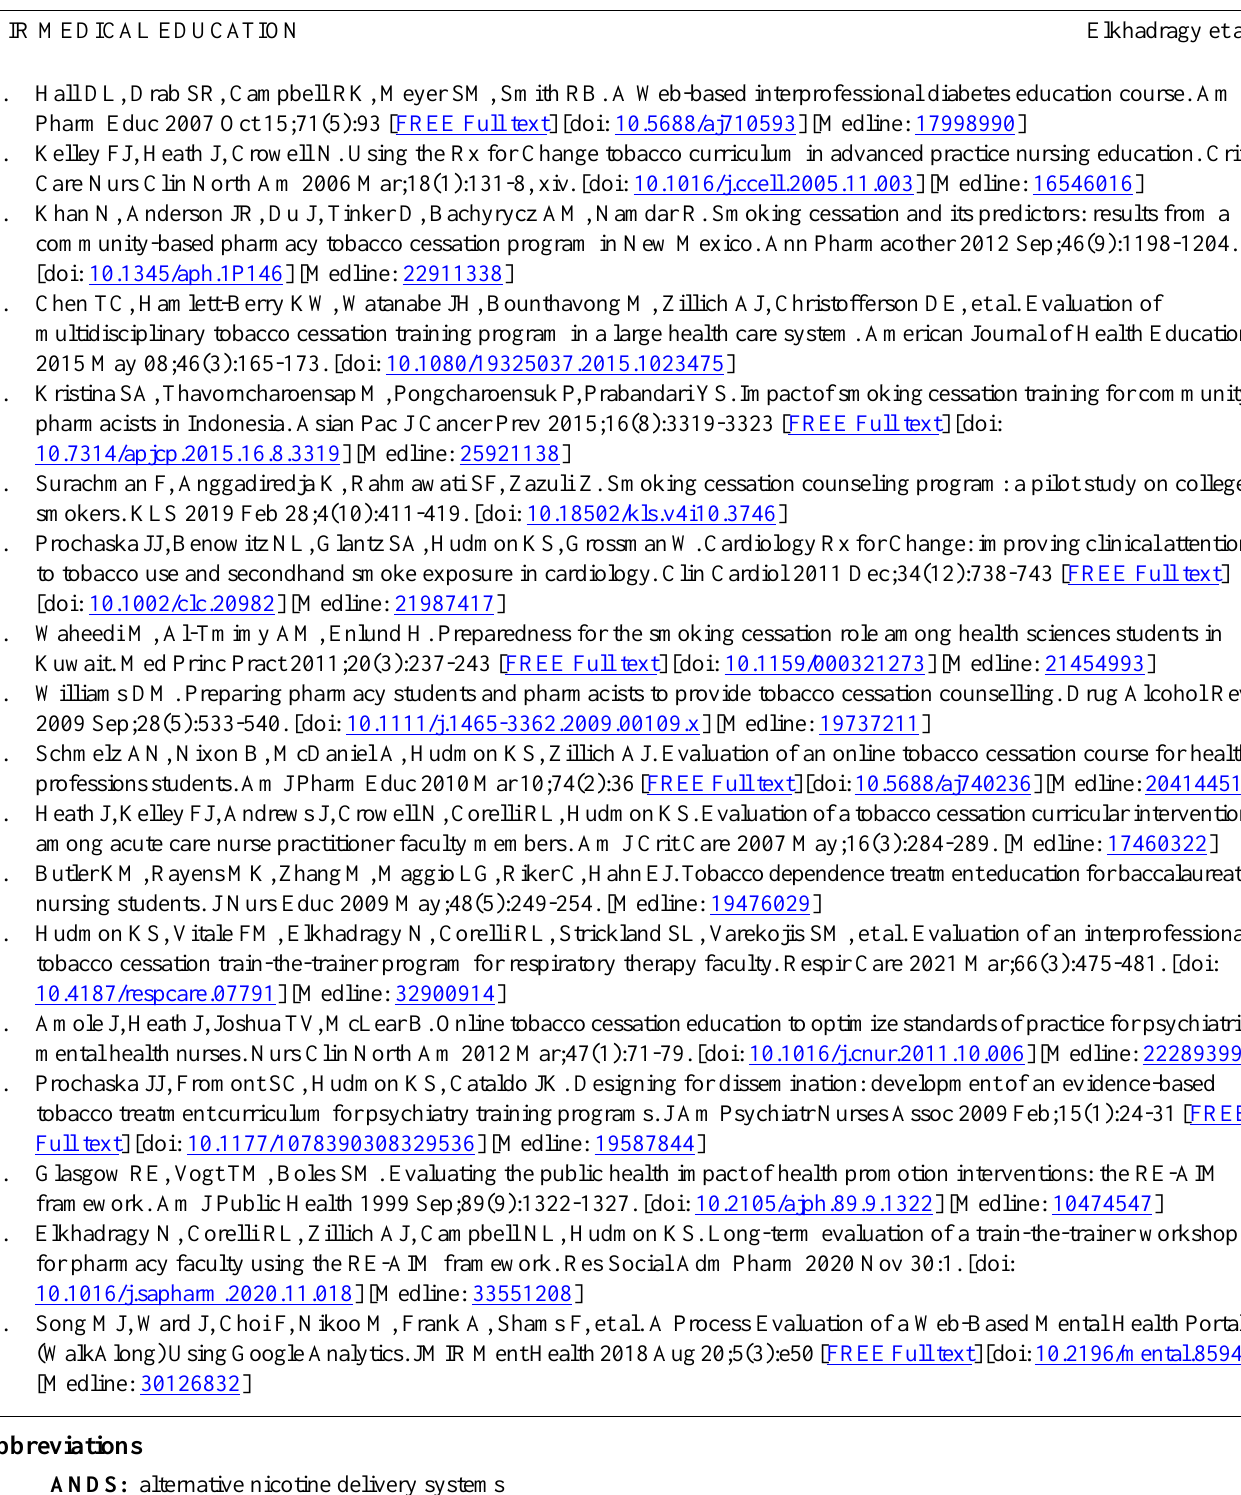
ANDS: alternative nicotine delivery systems OSCE: objective structured clinical